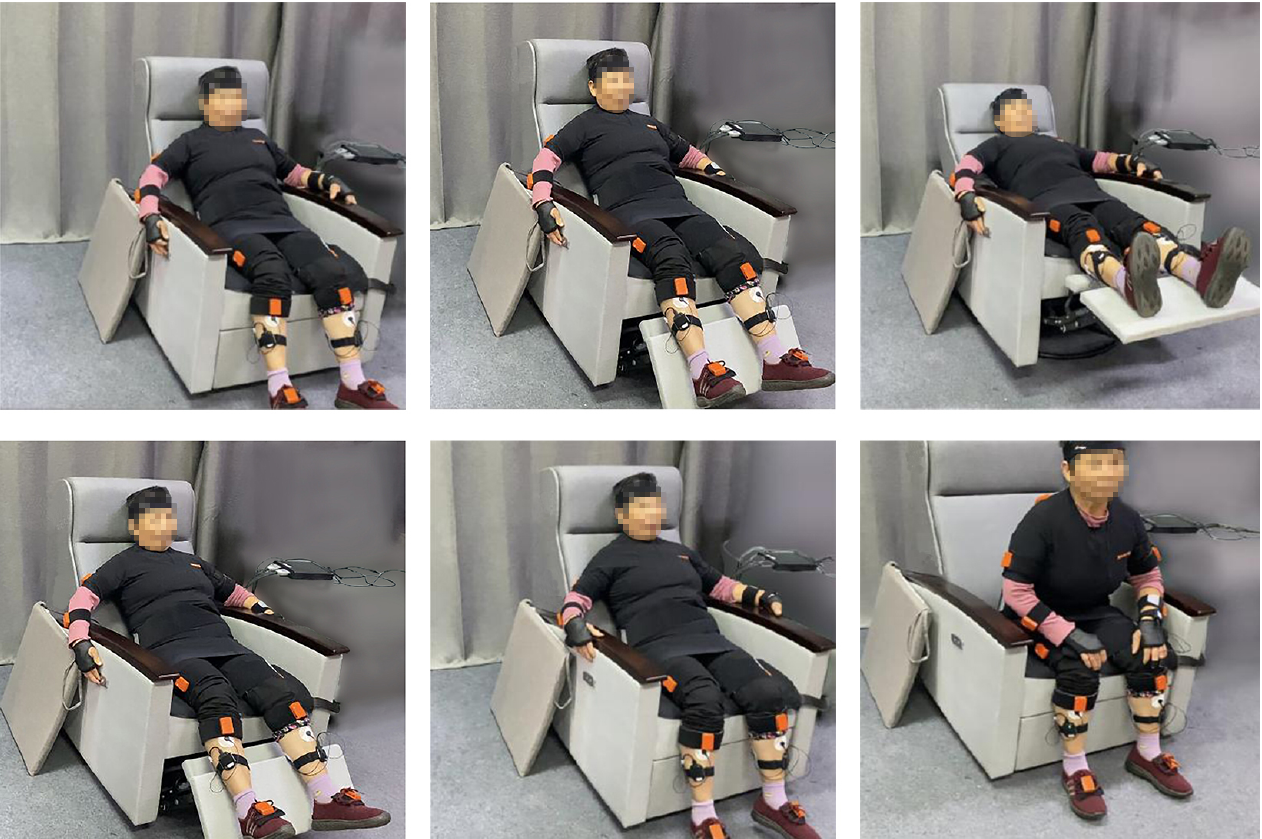
Figure 14. Experimental steps in the field. Elderly subjects were recruited to experience the proto- typed smart sofa and were given physiological information modules to complete the experience.